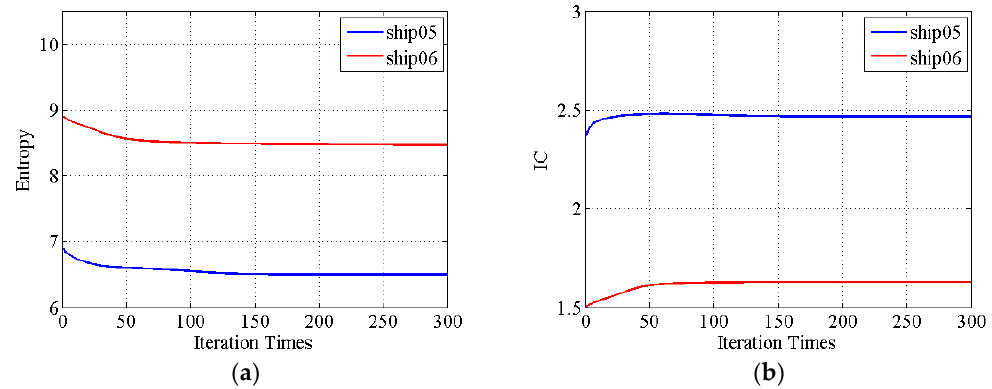
Figure 18. The entropies and IC values convergence of two sub-images versus the number of iterations. ( a ) Entropies change of the two sub-images during iteration; ( b ) IC values change of the two sub-images during iteration.